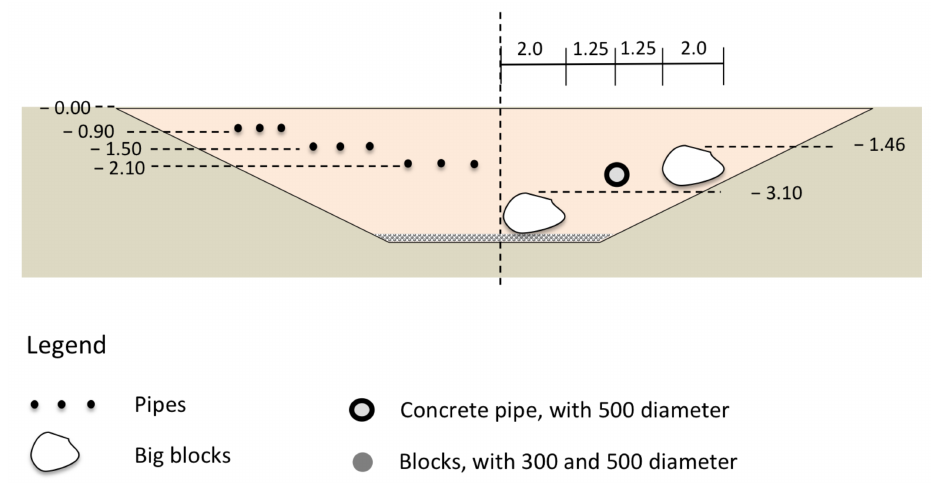
Figure 11. Transversal section of the Gneiss 14/20 gravel region, showing the embedded targets and their positions. All distances are expressed in meters.